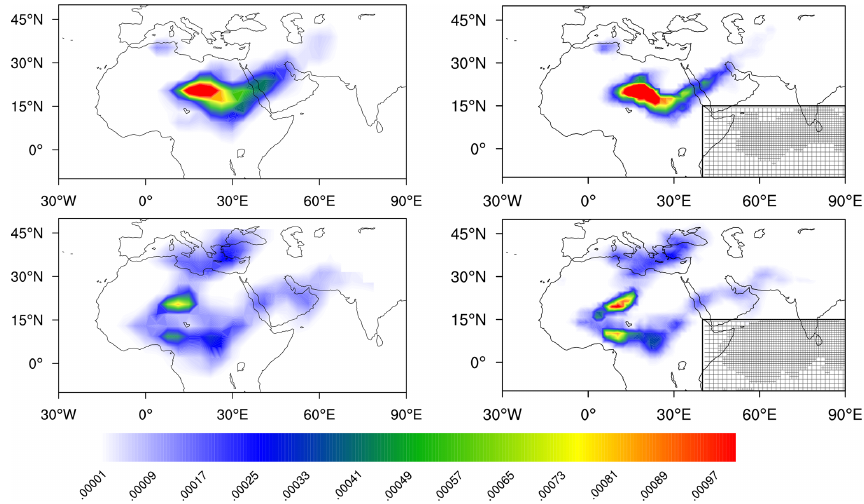
Figure 24. Dust mixing ratio of DU_AI (mgkg − 1 ) at 800hPa on 3 and 6 October at a model resolution of T 31 L 31 using our modified transport scheme in the region of [10 ◦ S, 50 ◦ N] × [30 ◦ W, 90 ◦ E]. In the left panel, the entire model runs on T 31 L 31. In the right panel, the dust transport is on adaptive meshes and the rest of the model is on T 31 L 31. The insets in the right column show the mesh